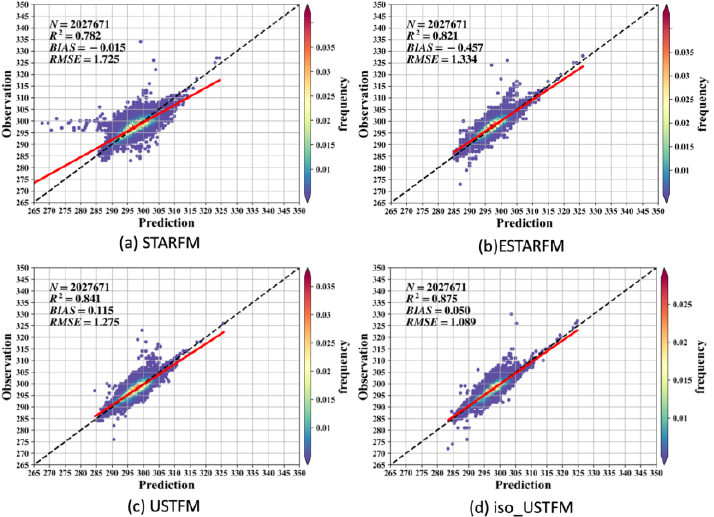
Figure 12. Scatter plot of predicted LST using these three models with Landsat7 LST on 20 Novem- ber 2001.